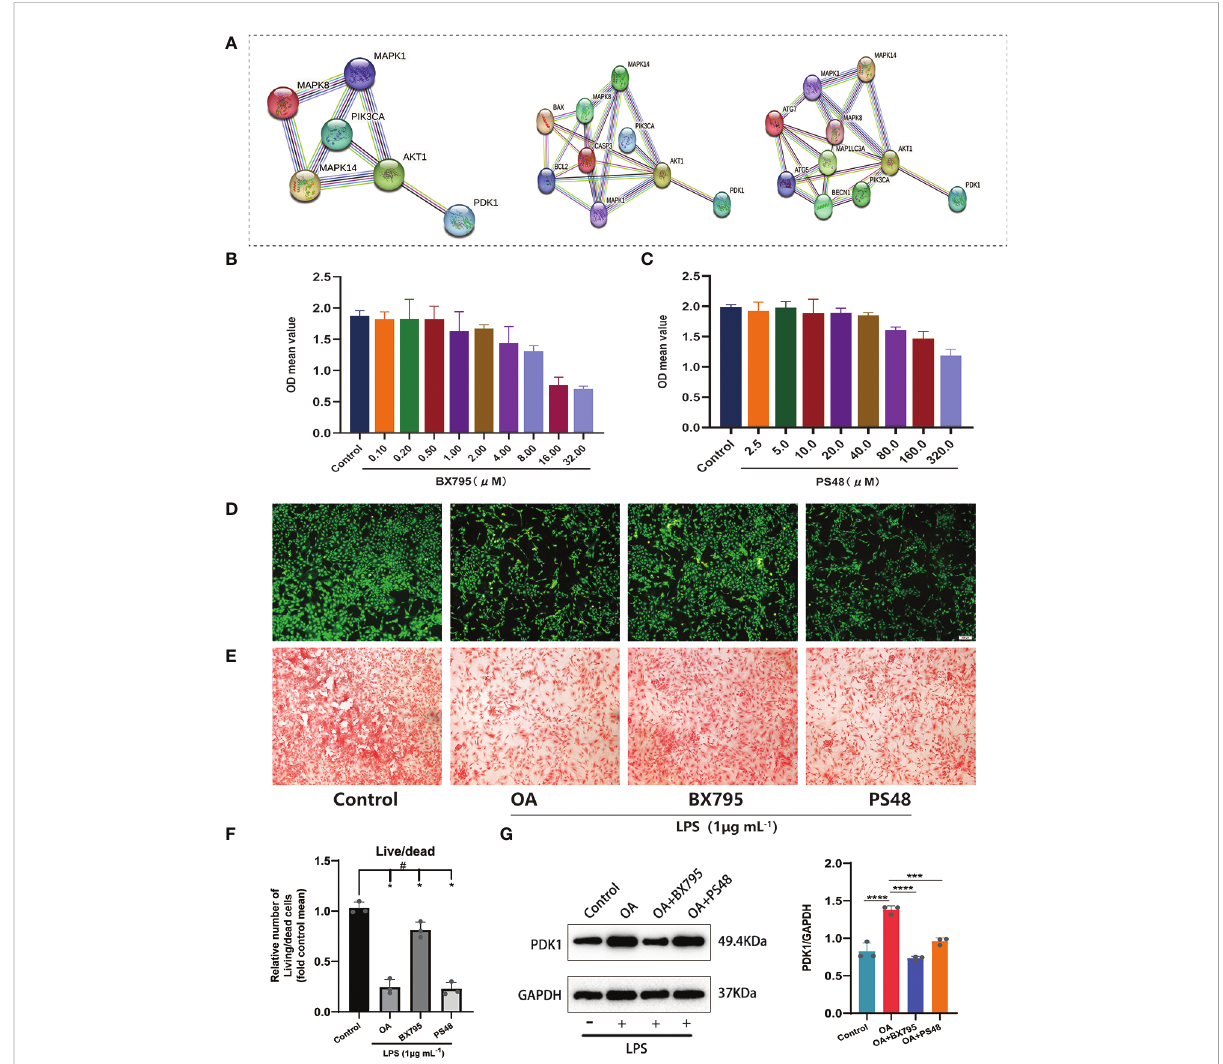
FIGURE 6 Exploring the potential signaling pathway of PDK1 involved in OA disease. (A) PPI network between PDK1 and the MAPK, PI3K/AKT signaling pathways, apoptosis, and autophagy-related mediators. Cytotoxic effect of different (B) BX795 (0.1-32 m M) and (C) PS48 (2.5-320 m M) concentrations on chondrocytes by the CCK-8 assay. (D) Calcein-AM/PI staining to detect the effects of BX795 (1 m M) and PS48 (5 m M) working concentrations on chondrocyte activity. Green represents viable cells, and red represents dead cells (scale bars=200 m m.). (E) Safranin O staining was used for GAG production. Control: untreated chondrocytes; OA: chondrocytes cultured with 1 m g/mL LPS; BX795: LPS induction of chondrocytes for 24 h, then 1 m M of BX795 was added to continue the culture for 24 h; PS48: LPS induction of chondrocytes for 24 h, then 5 m M of PS48 was added for culture for 24 h. (F) The quantitative analysis of Calcein-AM/PI staining (means ± SD, n=3, *P<0.05, signi fi cantly different with control; # P<0.05, signi fi cantly different as indicated). (G) Wstern blot analysis veri fi ed that BX795 inhibited PDK1 protein expression and quanti fi cation (means ± SD, n=3, *** p < 0.001; **** p <